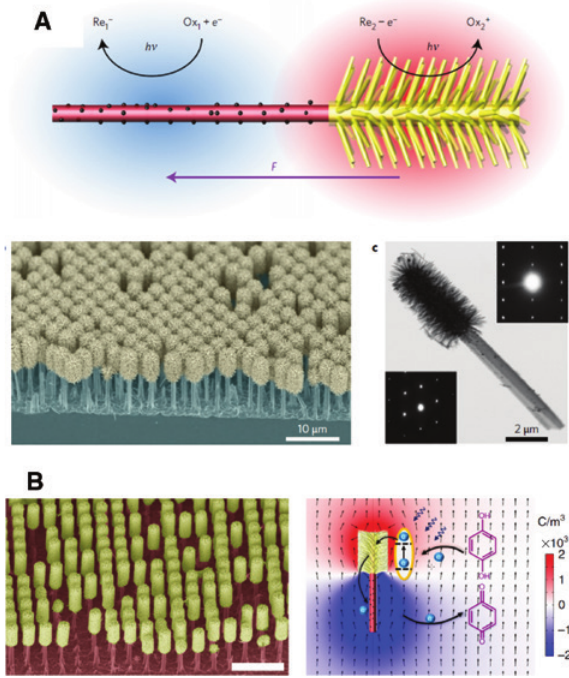
Figure 10: Various asymmetric branches structure of light-driven micro/nanomotors. (A) Schematic of the Janus Si/TiO /Pt 2 micromotor with TiO branches [70]. Copyright 2016, Nature 2 Publishing Group. (B) Improved Si(trunk)/TiO (branch) asymmetric 2 branches structure with the branches modified with dyes to enhance the photon absorption efficiency [108]. Copyright 2017, Nature Publishing